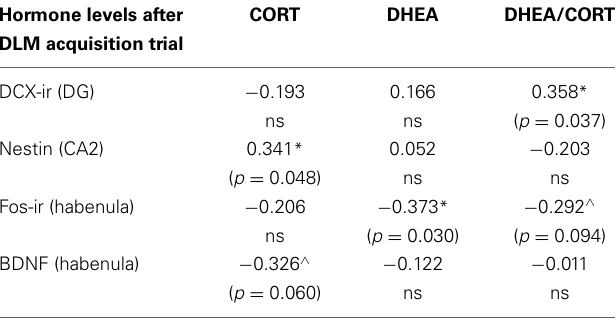
Table 2 | Correlations among neural activation and hormonal metabolites levels after the dry land maze (DLM) acquisition trial.